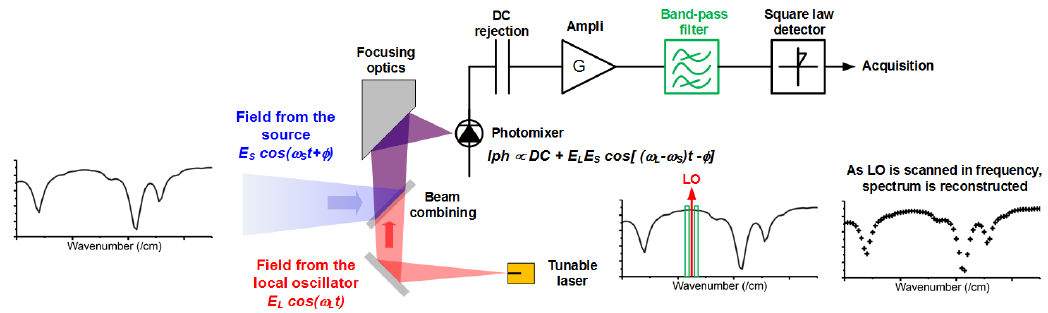
Figure 2. Schematic illustrating the principle of a laser heterodyne spectro-radiometer operating in the LO sweep mode.